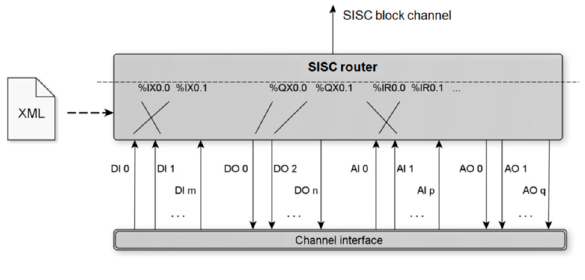
Figure 8. SICS router.